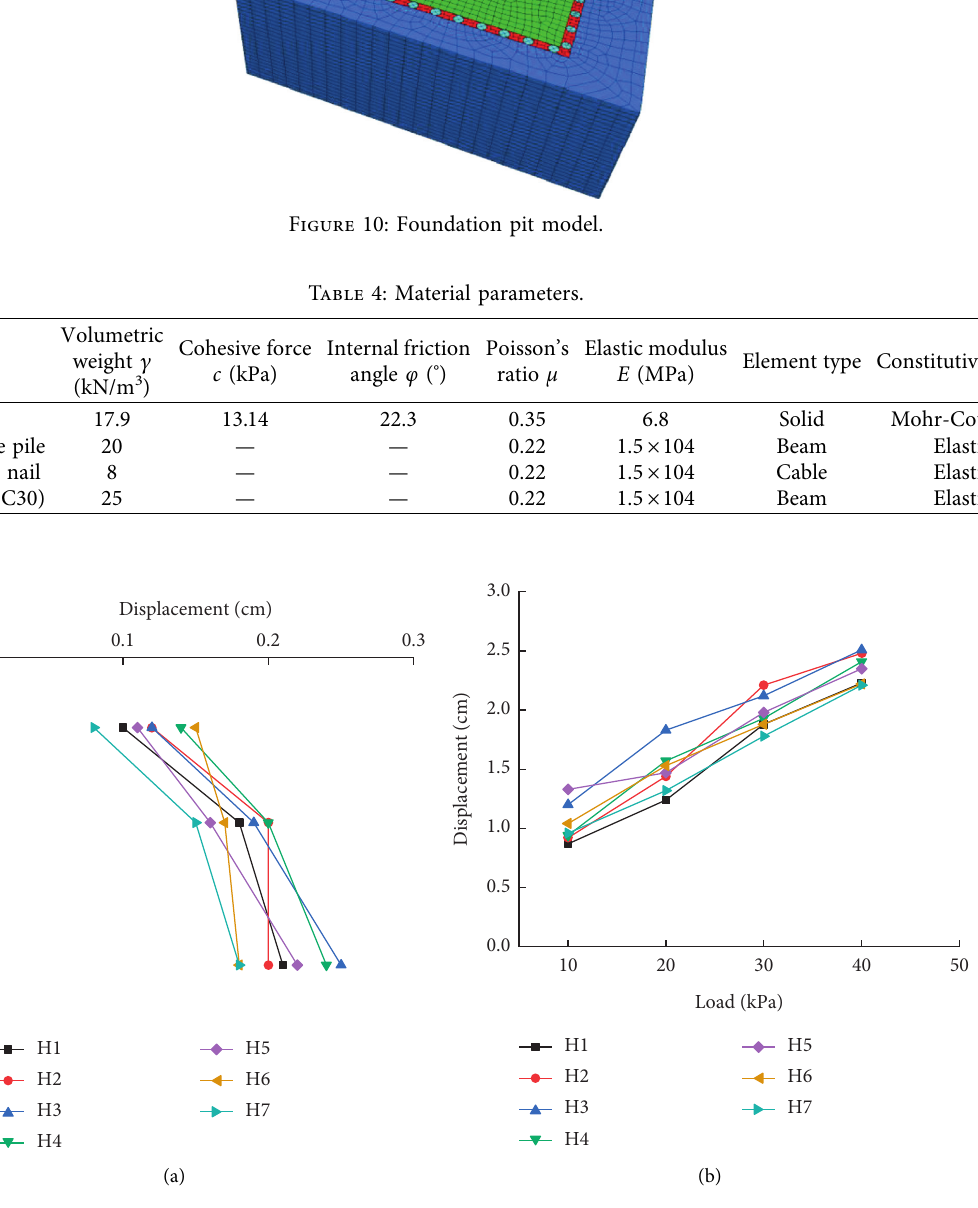
Figure 11: Distribution curves of foundation pit ground settlement. (a) Excavation stage. (b) Loading stage.